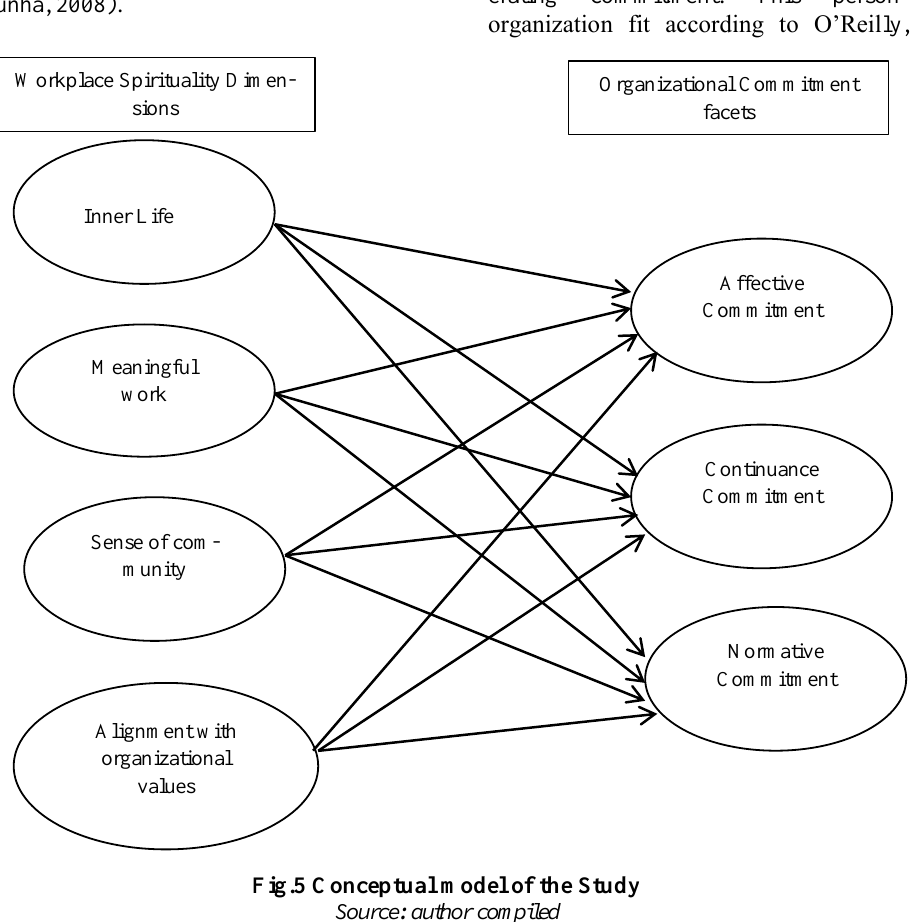
Fig.5 Conceptual model of the